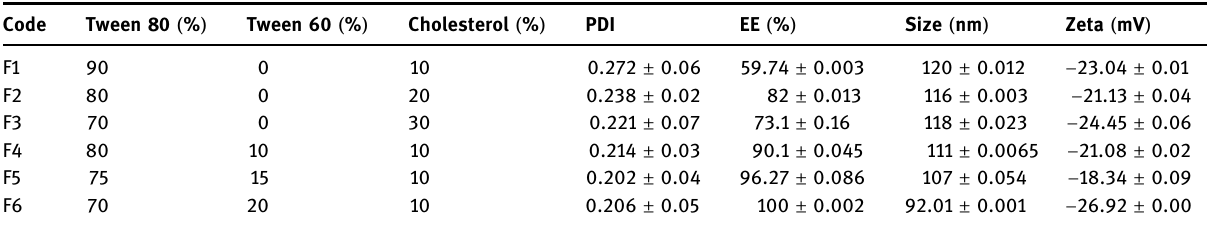
Table 1: The impact of di ff erent molar ratios of Tween 80, Tween 60 and cholesterol, on size, zeta potential, entrapment e ffi ciency ( EE% ) , PDI and release percentage ( R ) within the modi fi ed